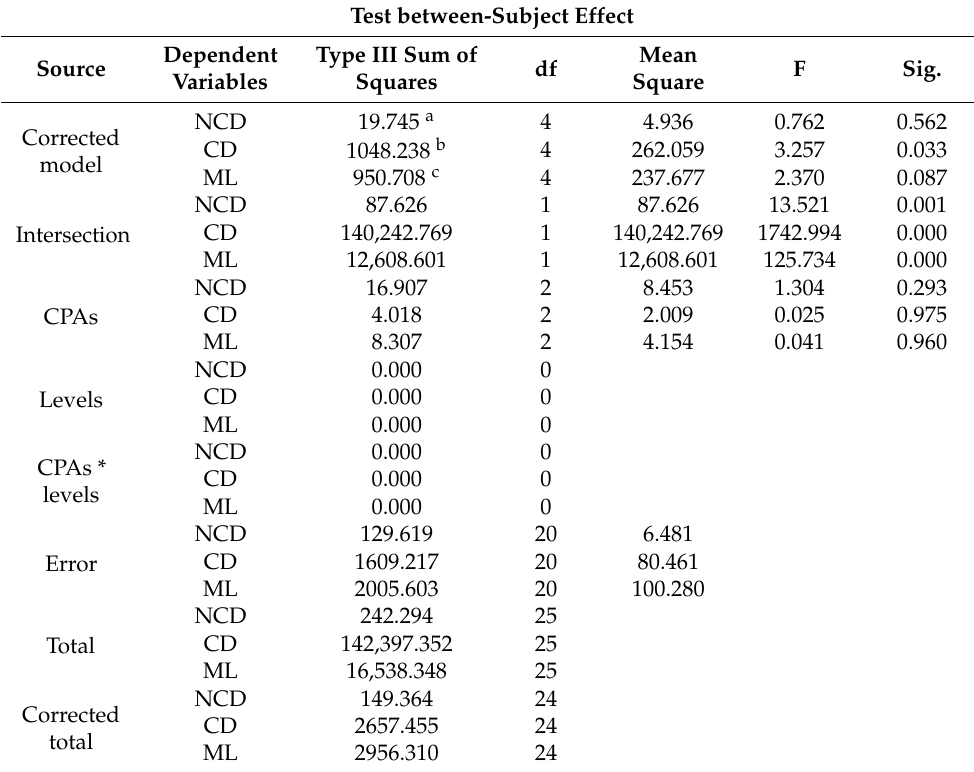
a. R squared = 0.132 (R squared fitted = − 0.041). b. R squared = 0.394 (R squared fitted = 0.273). c. R Figure 2. Percentage of cell viability of Scenedesmus sp. on day zero after thawing. No cell damage squared = 0.322 (R squared fitted = 0.186). * means interaction between (NCD), with cell damage (CD) and marked lesions (ML) of the evaluated treatments. Different let- ters for the three criteria indicate significant differences ( p < 0.05).